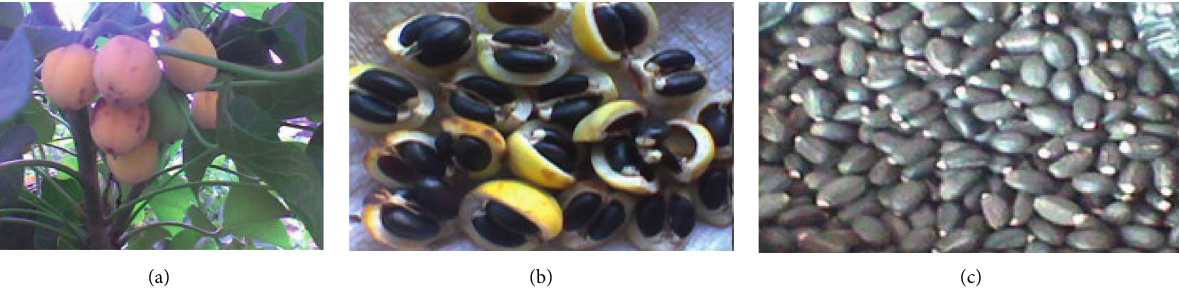
Figure 1: (a) Jatropha curcas L. tree with ripe fruits, (b) Jatropha curcas L. seeds with their shells, and (c) Jatropha curcas L. seeds with their